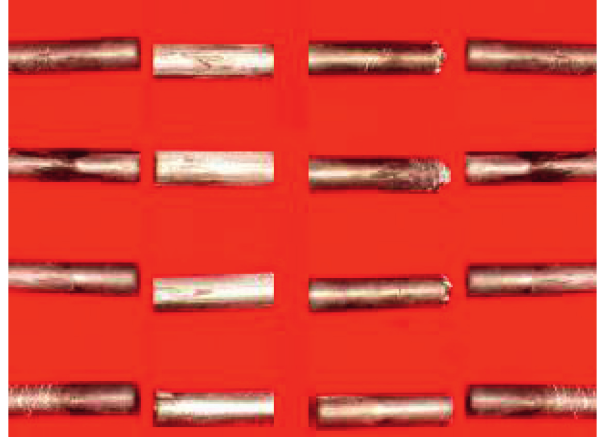
Figure 3: Image of wear test specimens.